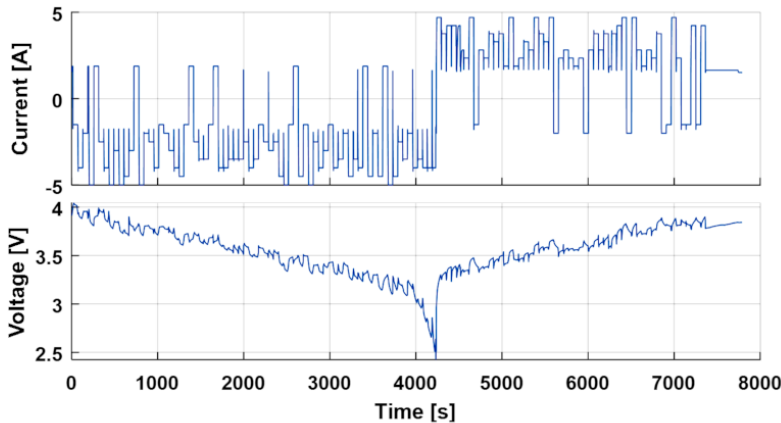
Figure 11. First-two dynamic load profiles of the aging cycles applied for model training and